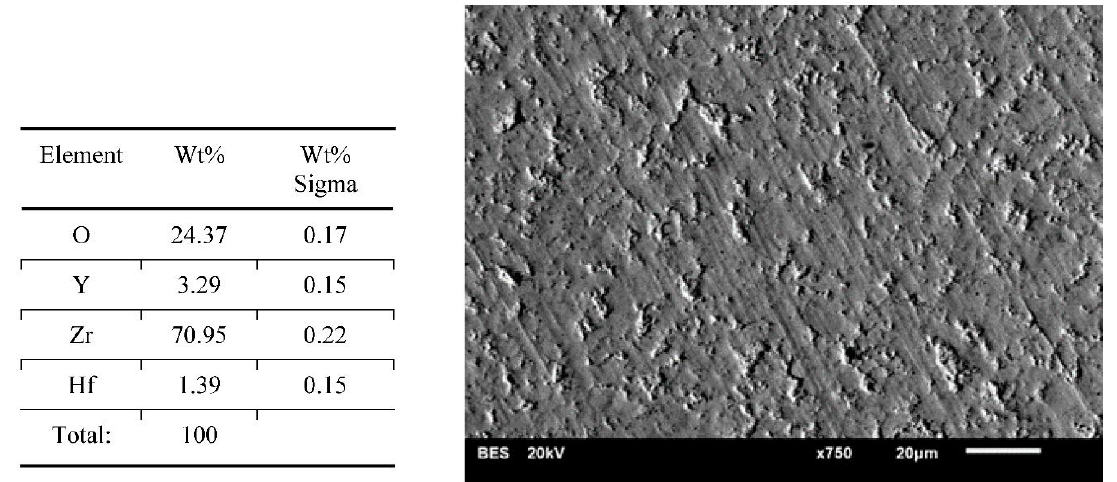
Figure 6. Chemical composition of the presented area and a backscattered electron image of a sample—dry ground 500 grit paper. Small features following lots of fine arrachments of the material.